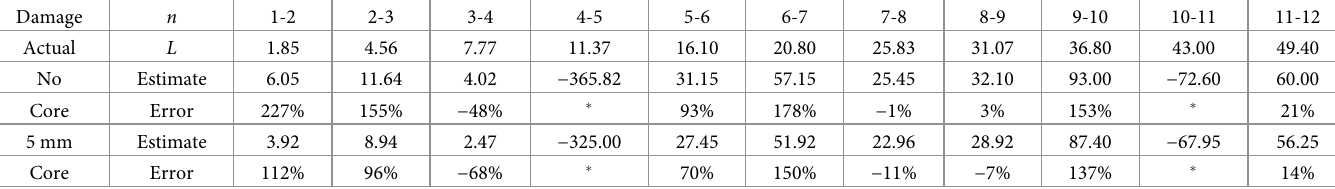
Table 5. Apocryphal Psalms ,